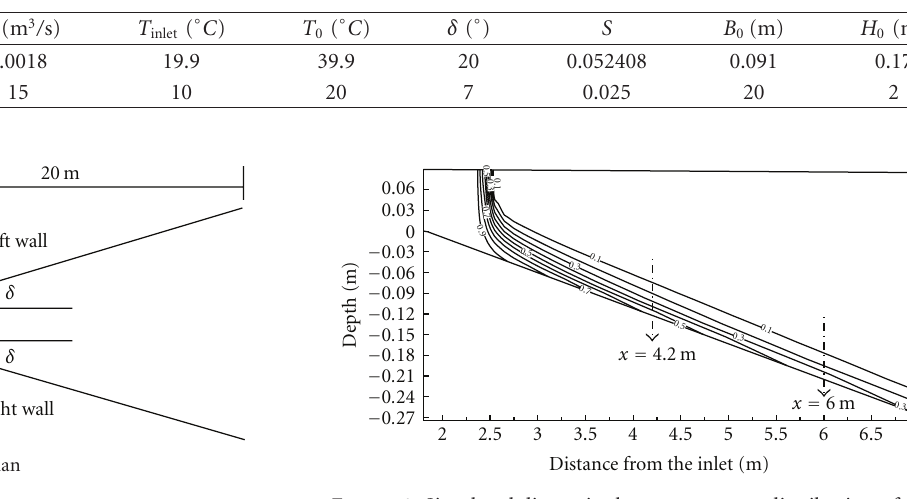
Figure 2: Simulated dimensionless temperature distribution of the Johnson and Stefan experiment [31] at a quasiequilibrium